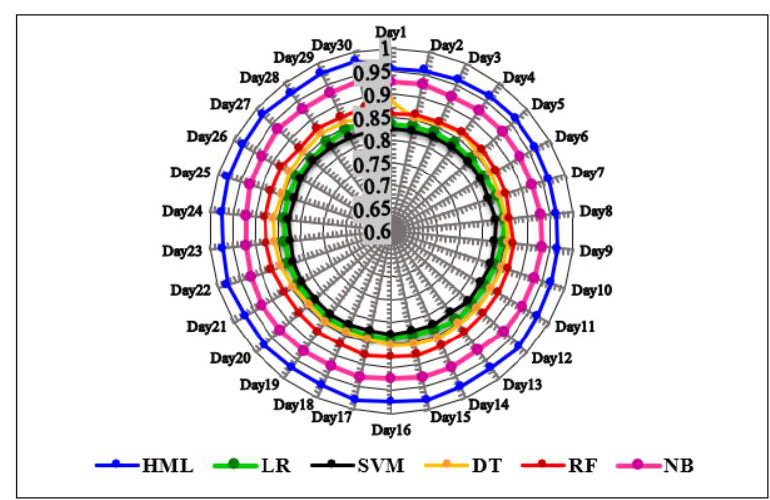
Figure 8. Outcomes of the third comparative experiment in a realistic environment with respect to AUC scores.